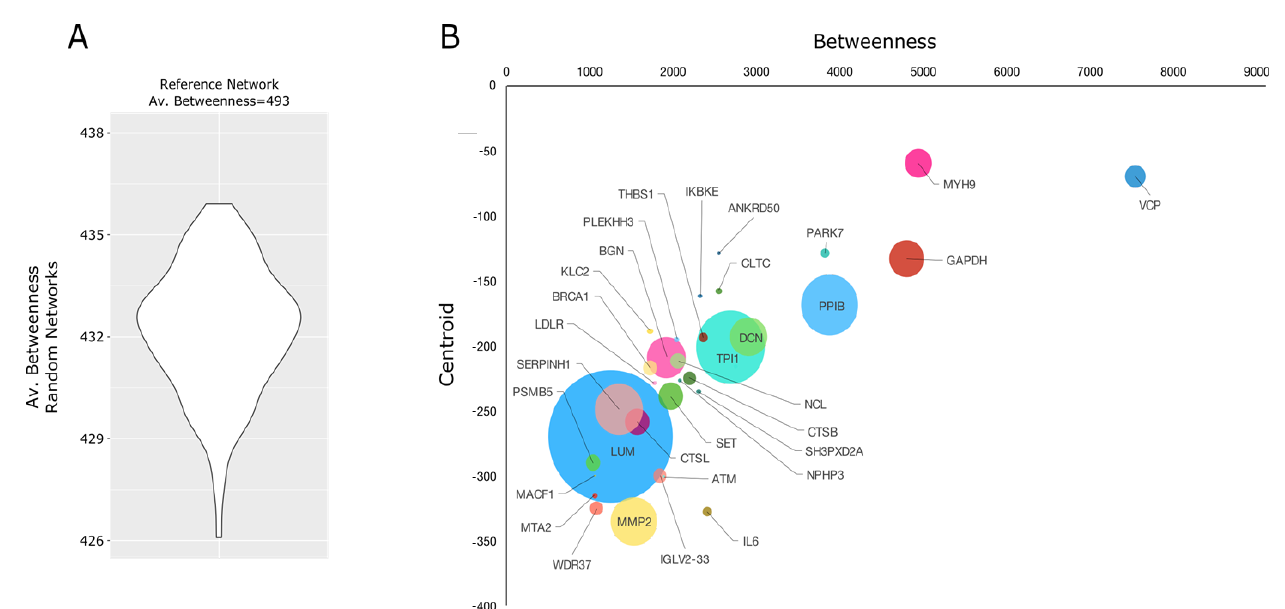
Figure 10. PPI network hubs in PPI network reconstructed from proteins secreted by Equus caballus mesenchymal stem/stromal. ( A ) Violin plot reporting the average Betweenness in Random networks. ( B ) PPI network hubs were selected considering Betweenness, Centroid, and Bridging (proportional to circle size) centralities; proteins were defined as hubs if all centrality values were above the average values calculated on the whole network.